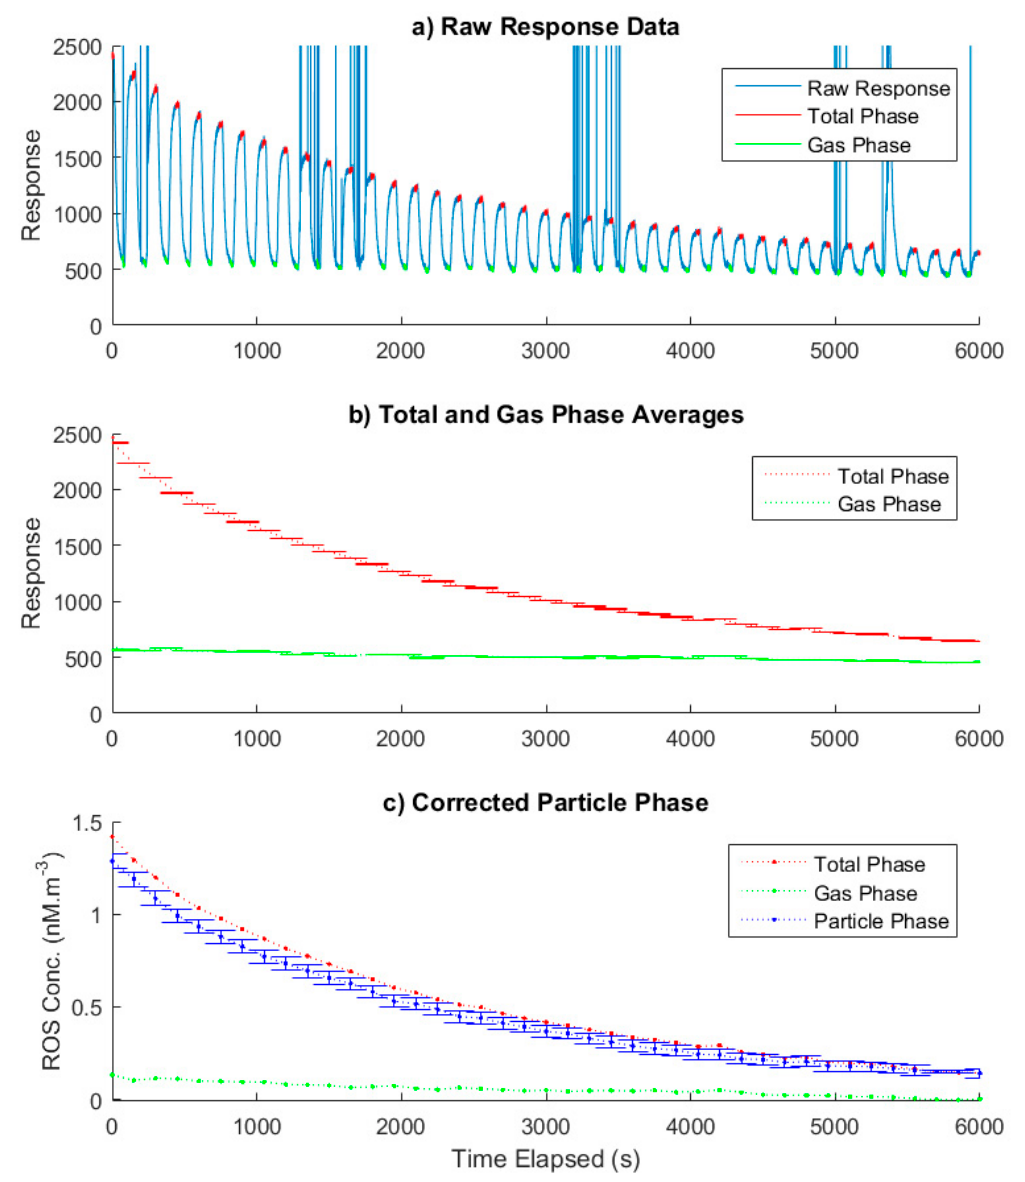
Figure 4. ( a ) The raw fluorescence response of the PINQ sample over time for side-stream cigarette smoke in a chamber. The alternating signal is caused by switching between filtered and unfiltered air. Sharp spikes in the signal are caused by bubbles in the sample line. The total and gas phase data points coloured indicate the data points averaged to generate the next plot in the figure. ( b ) The de-bubbled, trimmed and averaged plateaus and corresponding standard error of the alternating signal which correspond to the total and gas phase. ( c ) The final particle phase reactive oxygen species (ROS) concentration with standard error calculated by subtracting the interpolated gas phase from the total phase after correcting for background fluorescence and converting the signal to equivalent concentrations of BPEAnit-Me per cubic meter of air.